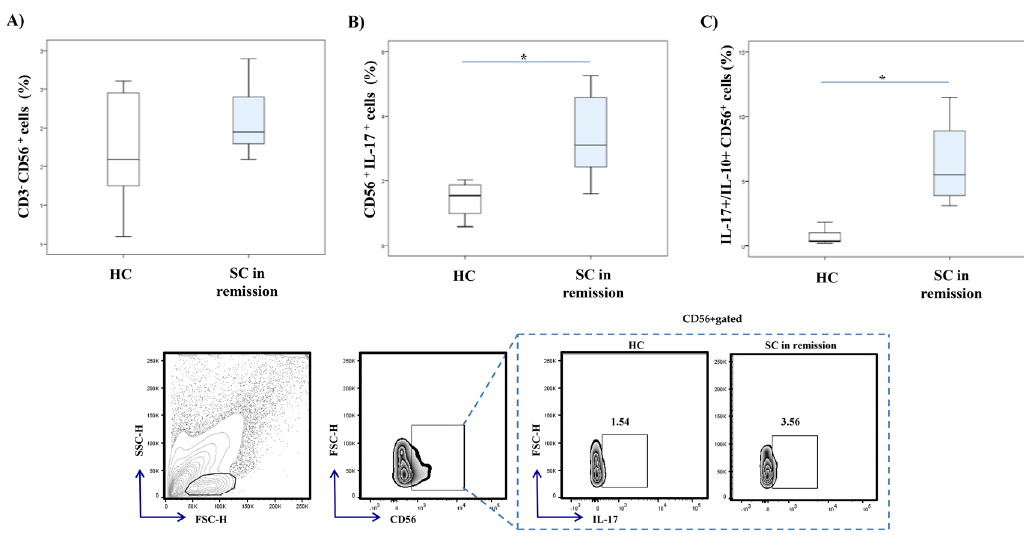
Figure 2. IL-17 and IL-10 production in peripheral blood NK cells. Cytokine production of peripheral blood NK cells was examined by flow cytometry. The graph and representative FACS plots display the percentage of IL-17 producing CD56 + cells and IL-17 + / IL-10 + CD56 + cells ratio in peripheral blood of patients with stable schizophrenia and healthy controls, respectively. The Student’s t or Mann–Whitney U test was applied to evaluate statistically significant di ff erences between two groups, * p < 0.05. There were no significant di ff erences in the percentage of CD56 + NK cells between patients with SC in remission and HC ( A ). Significantly higher percentage of IL-17 producing CD56 + NK cells was observed in patients with SC in remission ( B ). The ratio of IL-17 and IL-10 expression on NK cells was significantly higher in patients ( C ). SC in remission—schizophrenia in remission; HC—healthy controls; FACS–fluorescence-activated cell